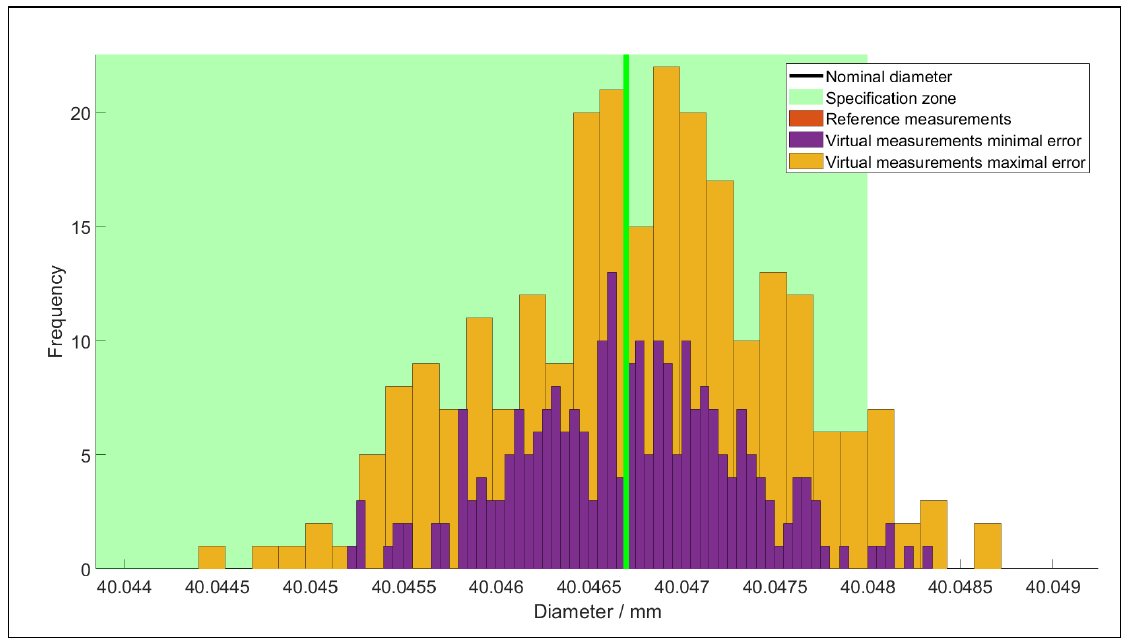
Figure 13. Section view of Figure 12.